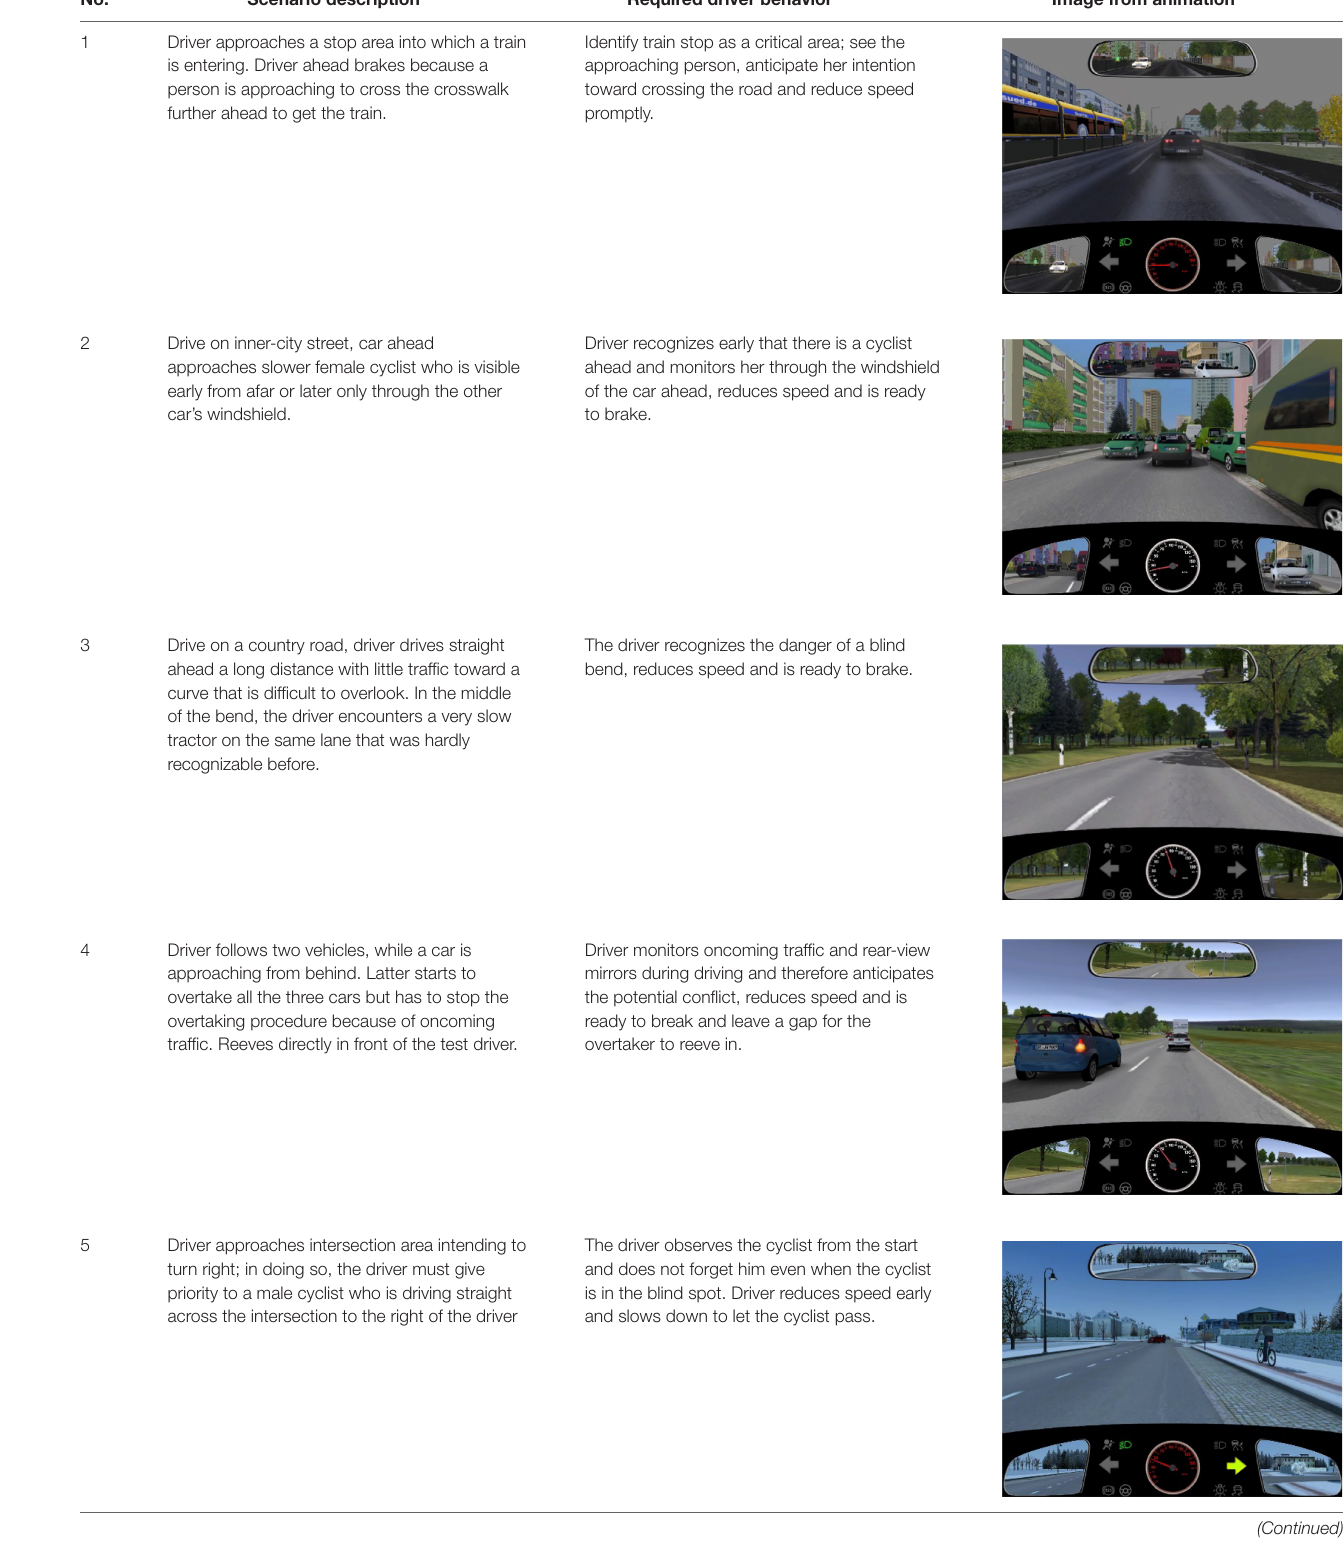
TABLE 1 | Description of the six simulated driving scenarios.